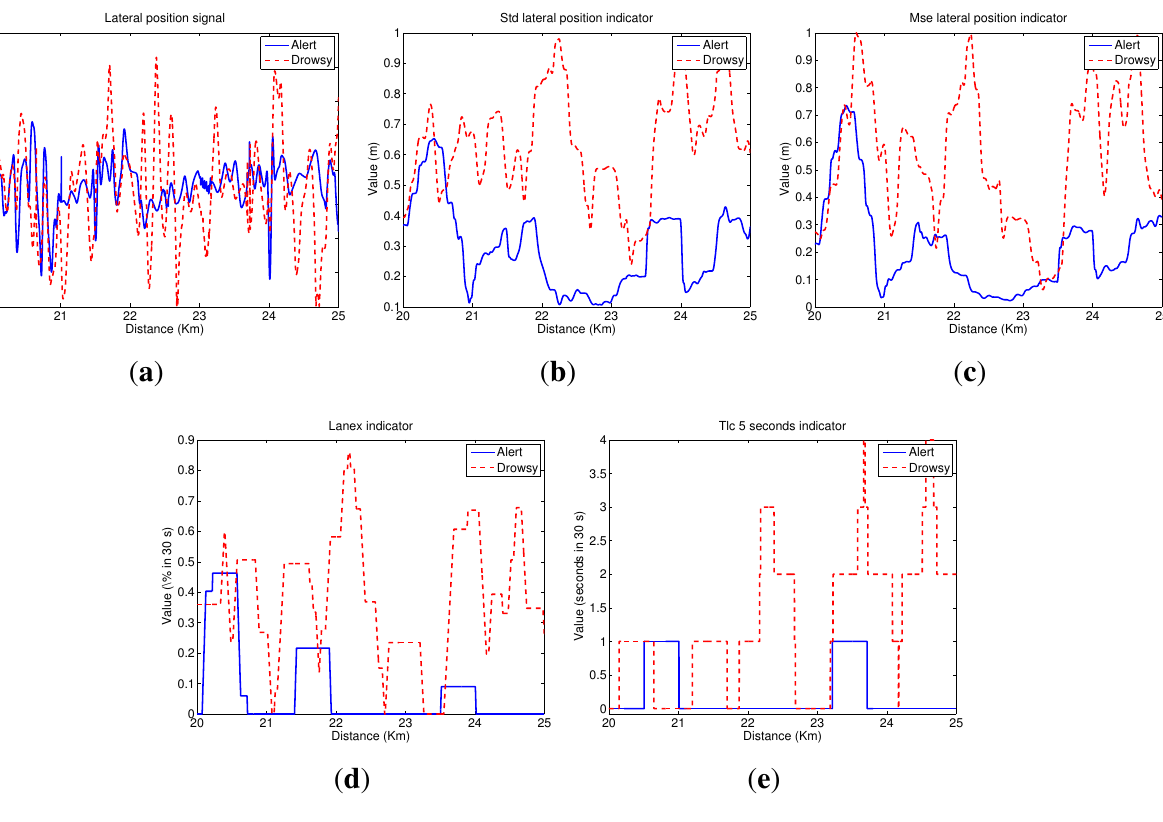
Figure 5. Lateral position indicators. ( a ) Lateral position signal; ( b ) the standard deviation of the vehicle lateral position ( ST D lp ); ( c ) the mean squared error of the lateral position with respect to the center of the driving lane ( MSE lp ); ( d ) optimized fraction of lane exits ( Lanex opti ); and ( e ) time to line crossing of 5 s ( T LC 5